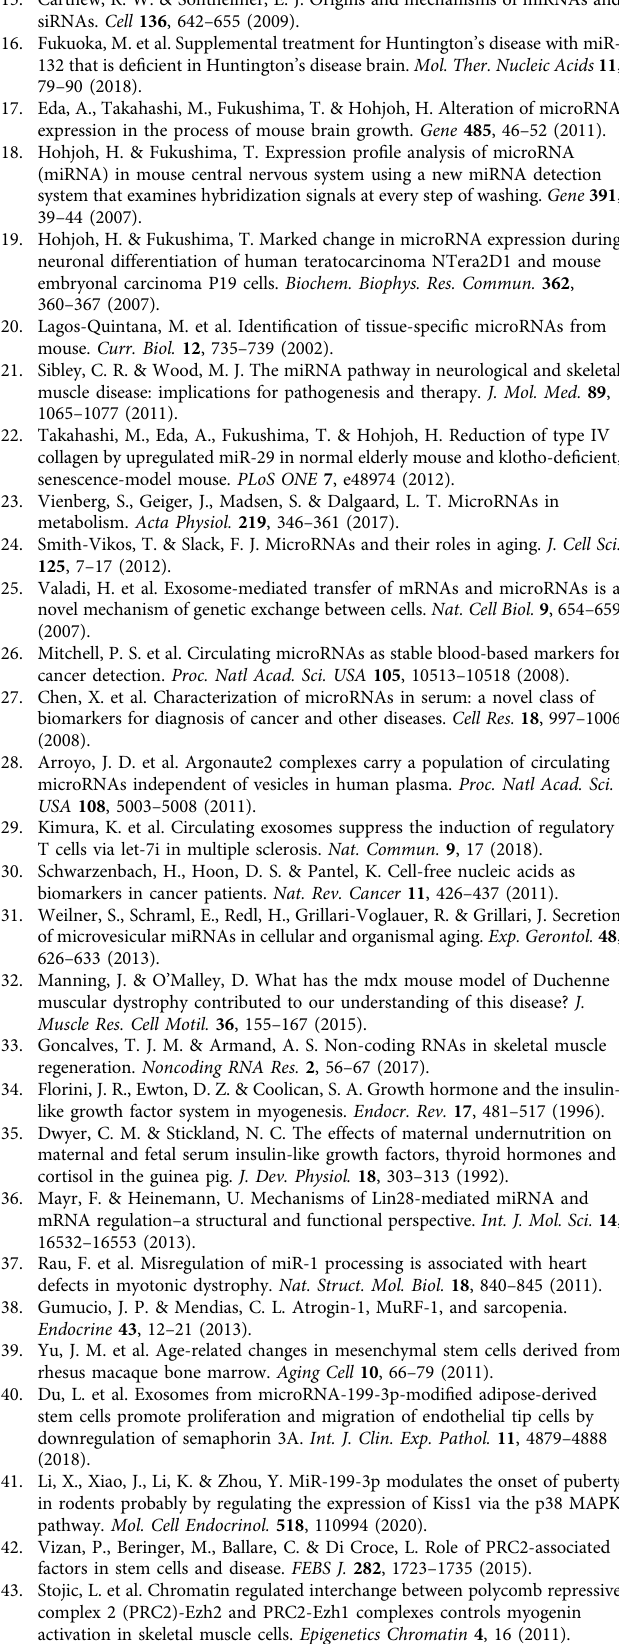
Supplementary Fig. 7. The primary antibodies used are indicated below with the product IDs and dilution ratios in parentheses: Anti-Suz12 (#3737, 1/1000), anti-Lin28b (#5422, 1/1000), and anti-Gapdh (#2118, 1/5000) were purchased from Cell Signaling Technology.